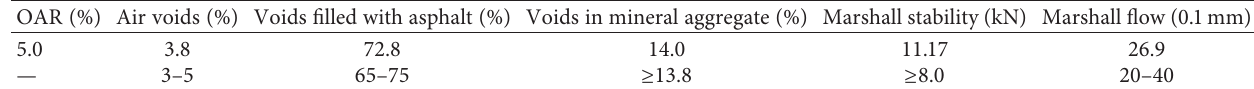
Table 4: Test results of asphalt mixture based on the